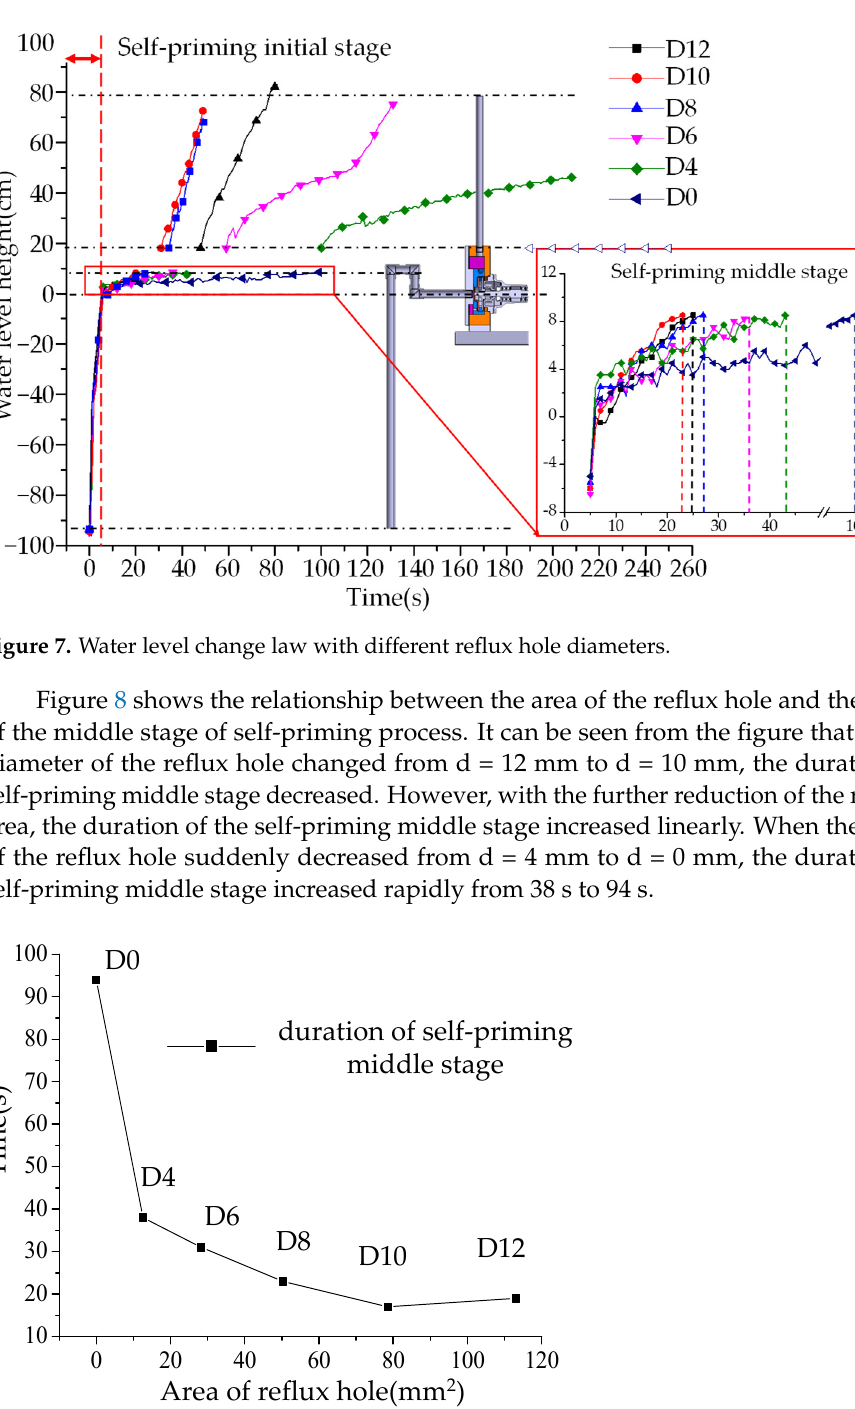
Figure 8. The relationship between the area of reflux hole and the time of the self-priming mid- stage.